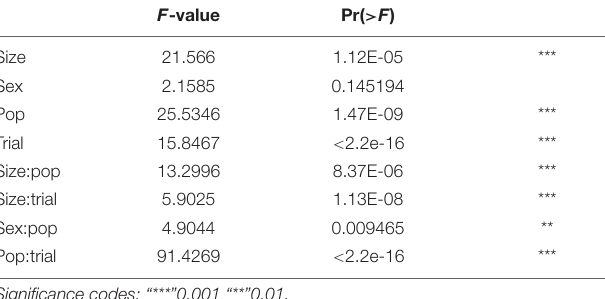
TABLE 3 | Type III analysis of variance table with Satterthwaite’s method for feeding latency across populations.